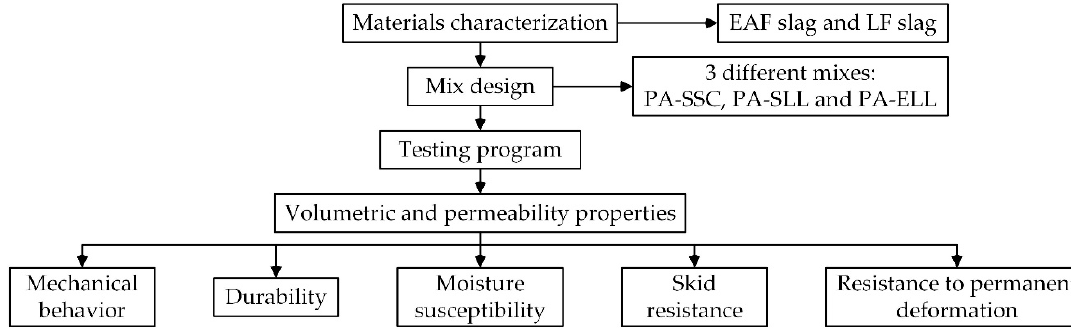
Figure 1. Experimental plan.